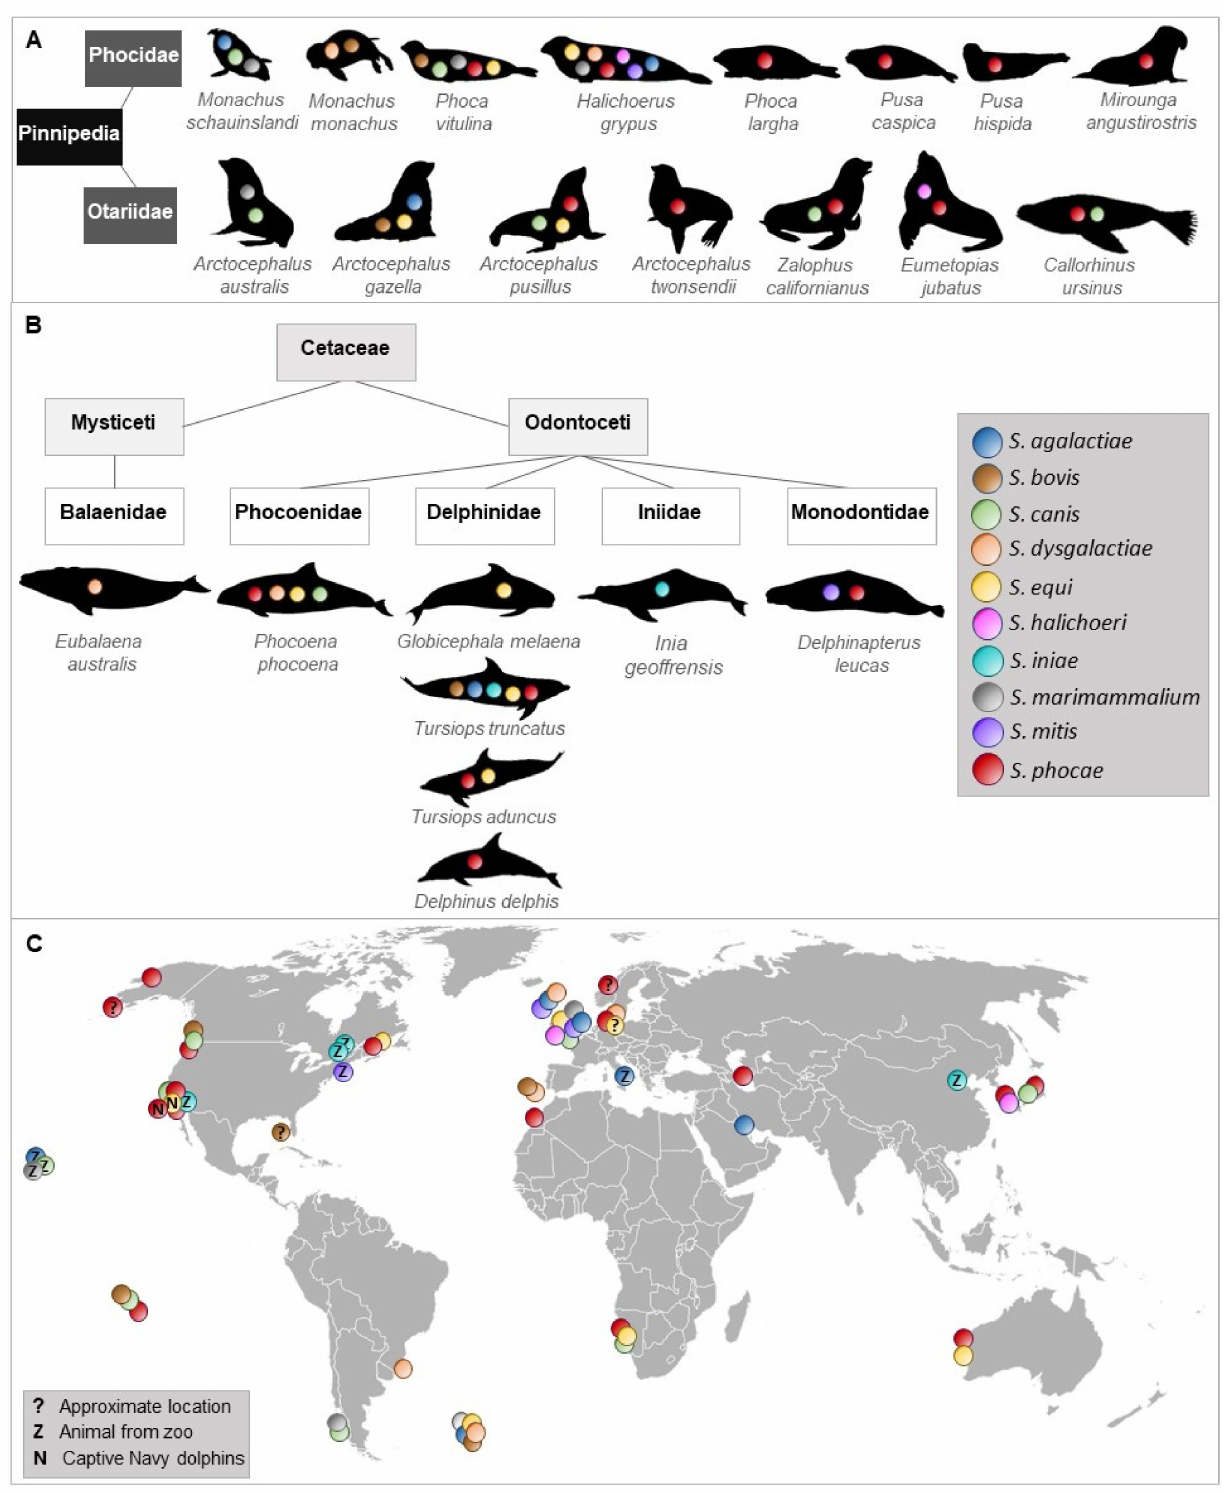
Figure 1. Occurrence of streptococcal species described in different marine mammals. Streptococcal species that have been isolated and identified at least twice in pinnipeds ( A ) and cetaceans ( B ). ( C ) shows a world map indicating location of streptococcal species detected in marine